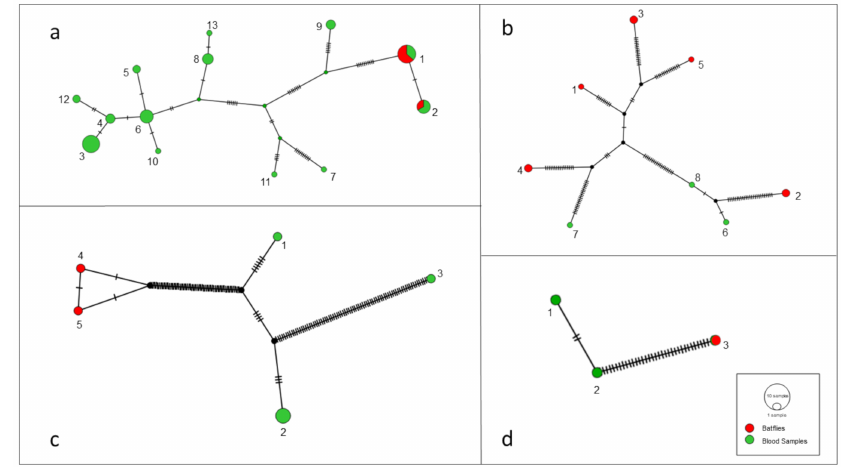
Figure 1. Genotype network with gltA ( a ), nuoG ( b ), rpoB ( c ) and ftsZ ( d ) sequences obtained from bat blood and ectoparasite samples obtained in the present